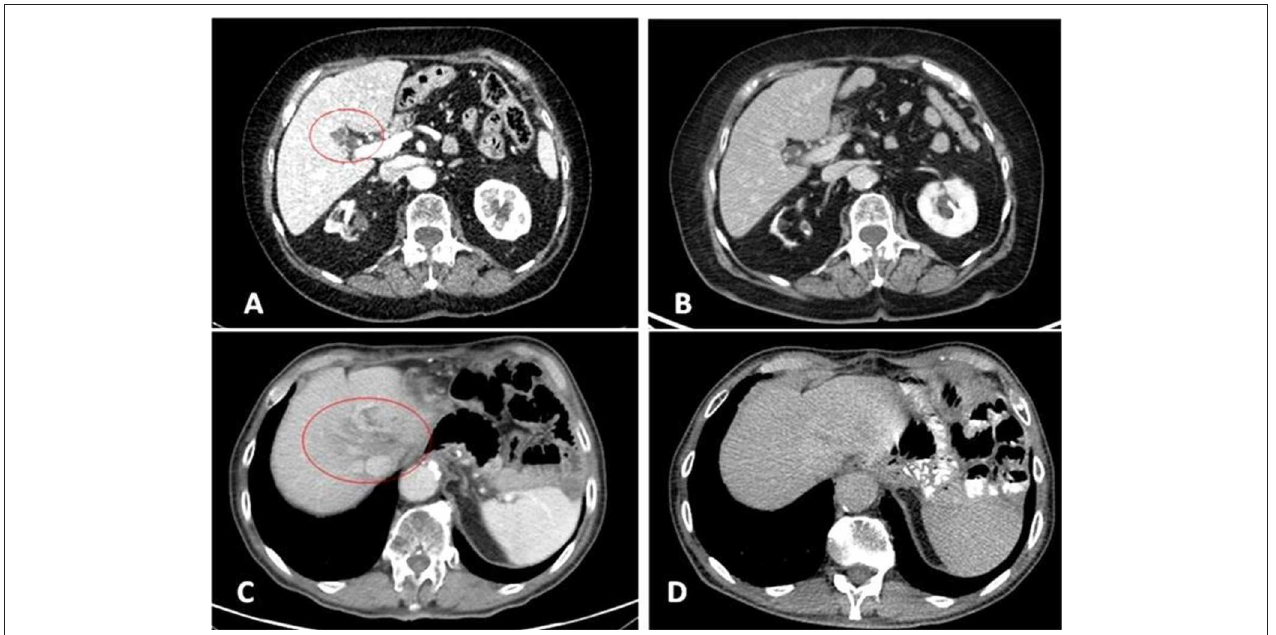
FIGURE 2 | 2017 pre-treatment ( A = patient 1; C = patient 2) and 2019 complete response CT scans ( B = patient 1; D = patient 2). Liver metastases at IV (A) and VIII (C) segment.